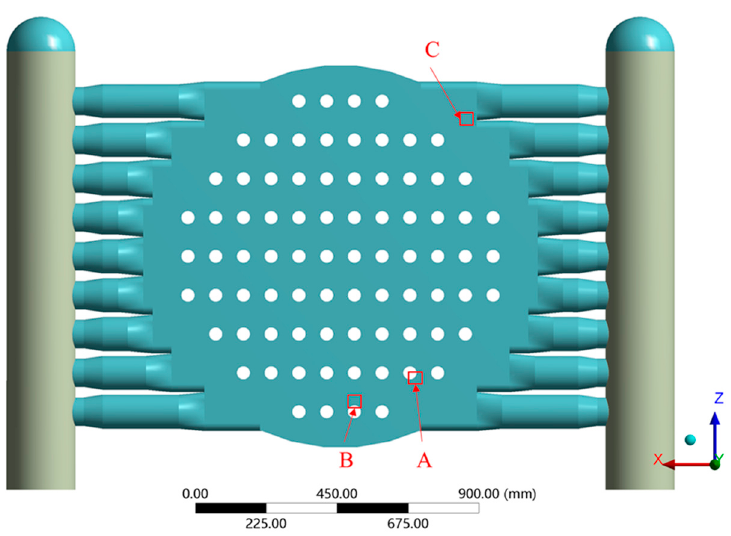
Figure 8. Three dangerous parts at the flat-round tubesheet.